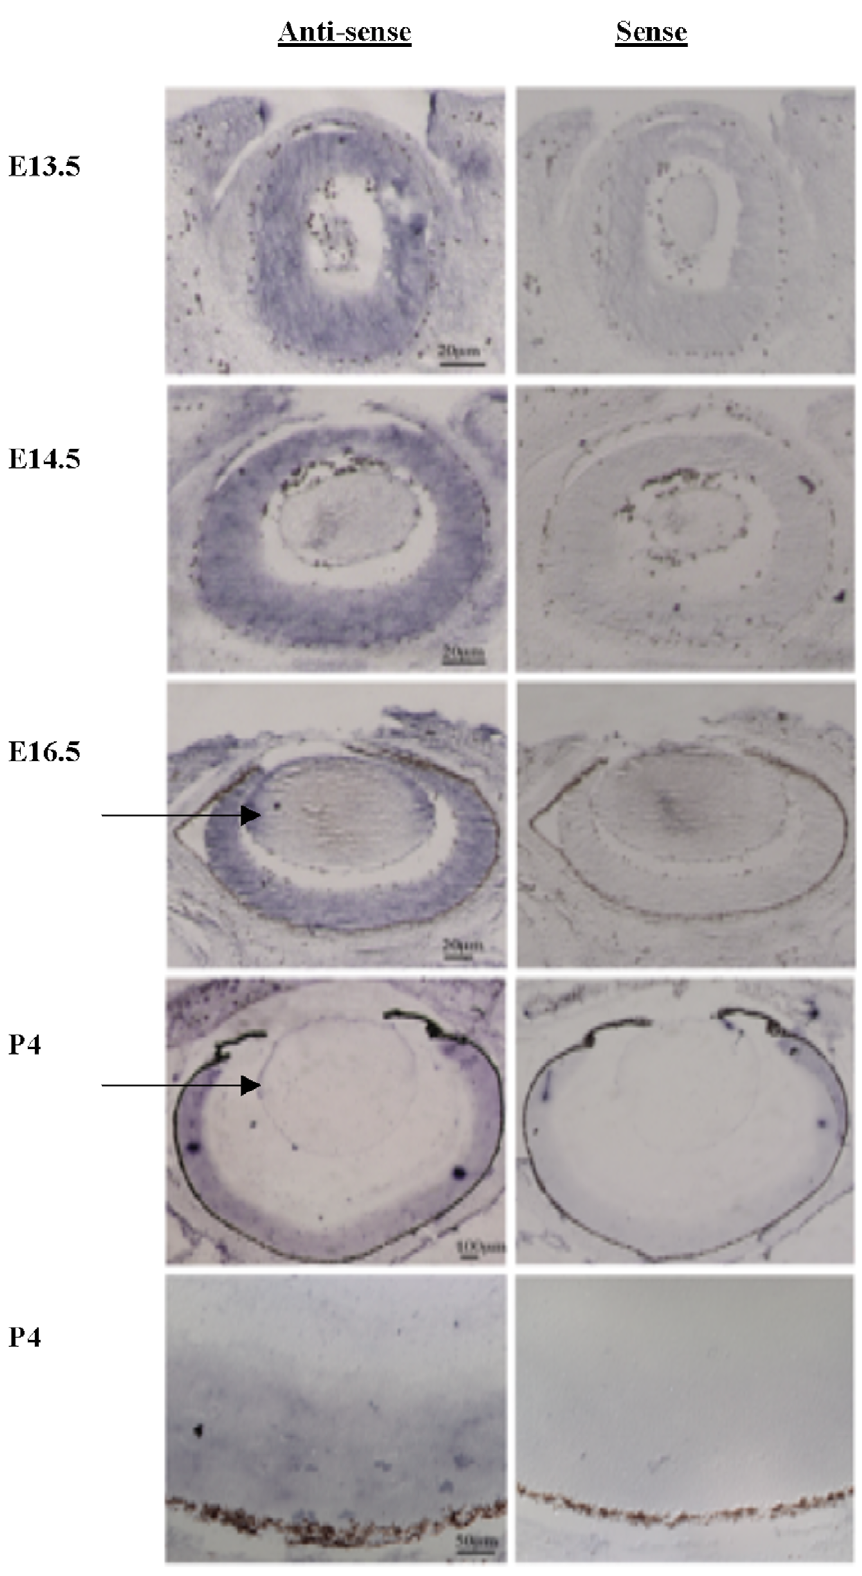
Figure 2. In-situ hybridization shows strong expression of TMX3 in the developing murine eye. Fig. 2. In-situ hybridization using antisense and sense riboprobes for TMX3 , showing expression in the murine developing eye at E13.5, E14.5, E16.5 and P4. An arrow points to the labeling of the lens epithelium at E16.5 and P4 with the TMX3 antisense probe.